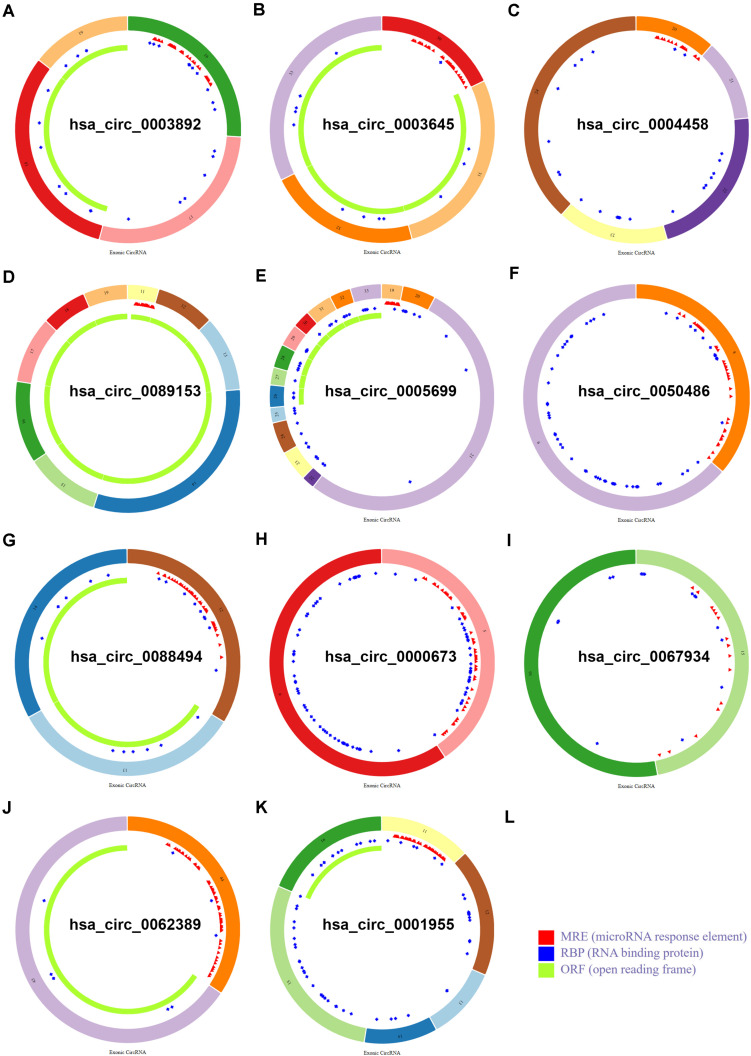
Structural patterns of the 11 circRNAs in the CSCD database. (A) The structural pattern of hsa_circ_0003892. (B) The structural pattern of hsa_circ_0003645. (C) The structural pattern of hsa_circ_0004458. (D) The structural pattern of hsa_circ_0089153. (E) The structural pattern of hsa_circ_0005699. (F) The structural pattern of hsa_circ_0050486. (G) The structural pattern of hsa_circ_0088494. (H) The structural pattern of hsa_circ_0000673. (I) The structural pattern of hsa_circ_0067934. (J) The structural pattern of hsa_circ_0062389. (K) The structural pattern of hsa_circ_0001955. (L) The representation of MRE, RBP, and ORF.